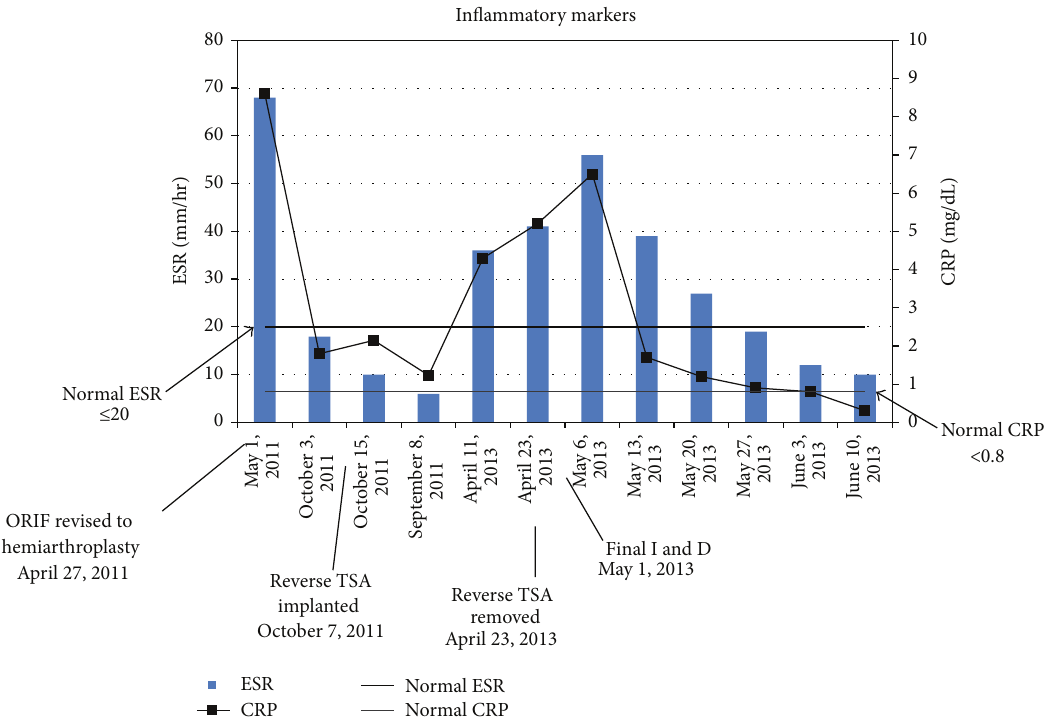
Figure 4: Inflammatory markers: C-reactive protein (CRP) and erythrocyte sedimentation rate (ESR) values throughout the patient’s course of treatment. Note that the bars are not scaled accurately along the abscissa with respect to time.